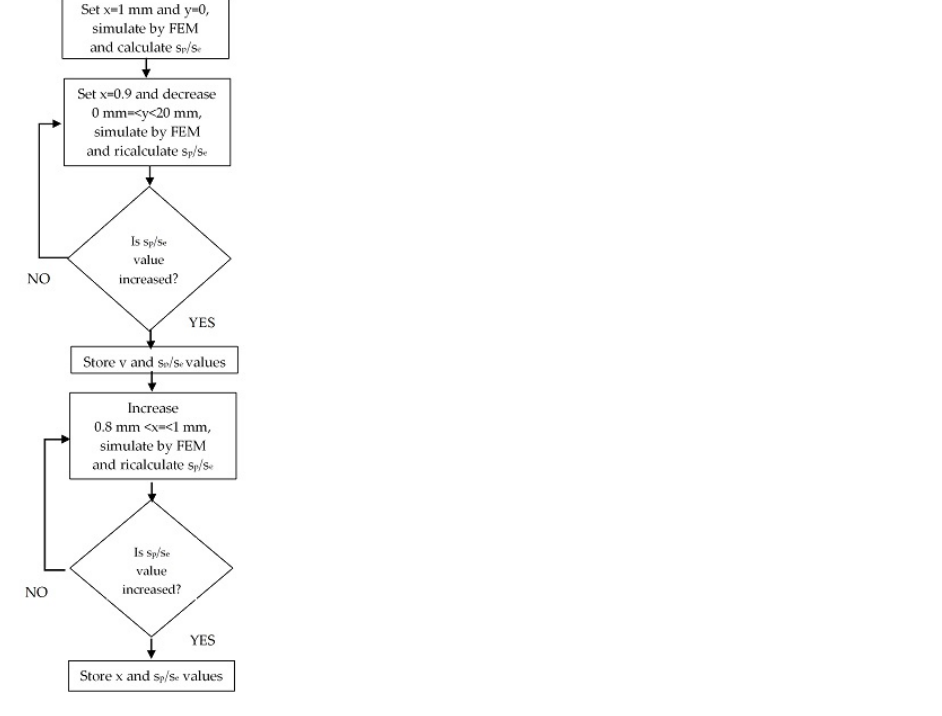
Figure 4. Flowchart of the proposed numerical approach.